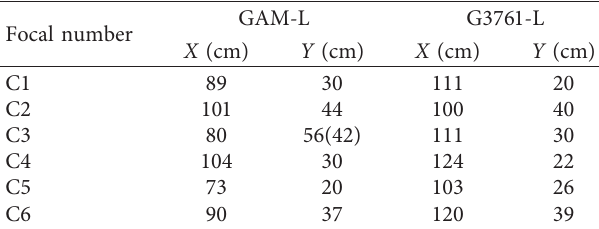
Table 8: The coordinates of the pulse sources on the plate-shaped rock.